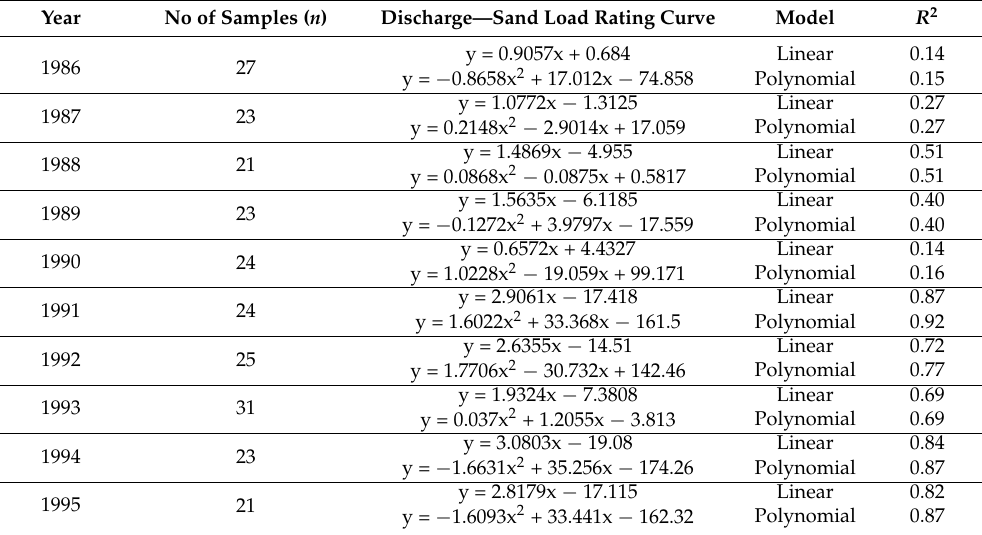
Table A1. Annual discharge-sand load rating curves developed for Tarbert Landing of the LmMR specifically during the period